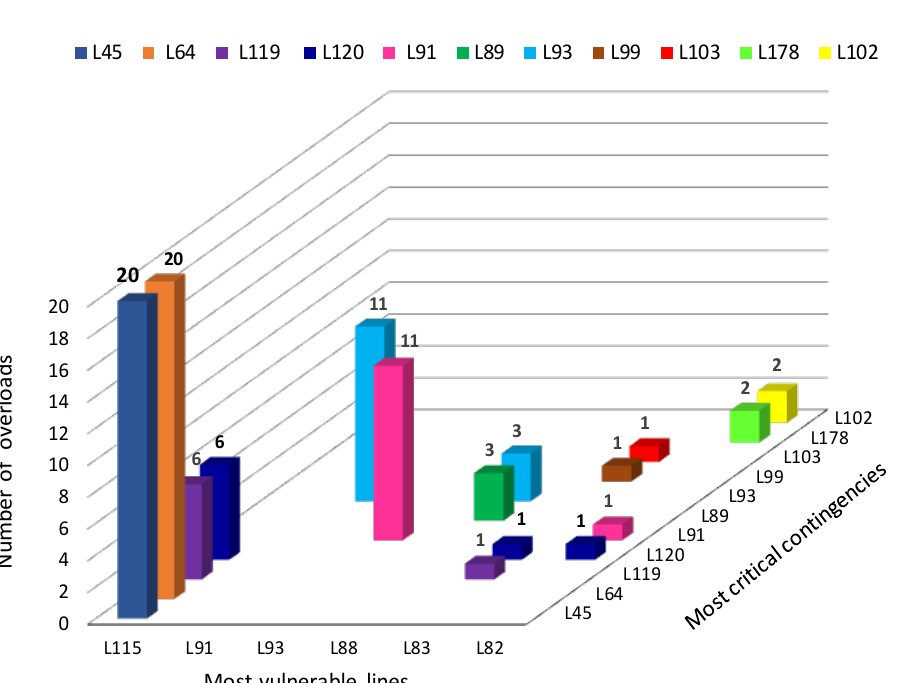
Figure 5. Mapping of vulnerable lines and critical contingencies considering TCF = 0.8.